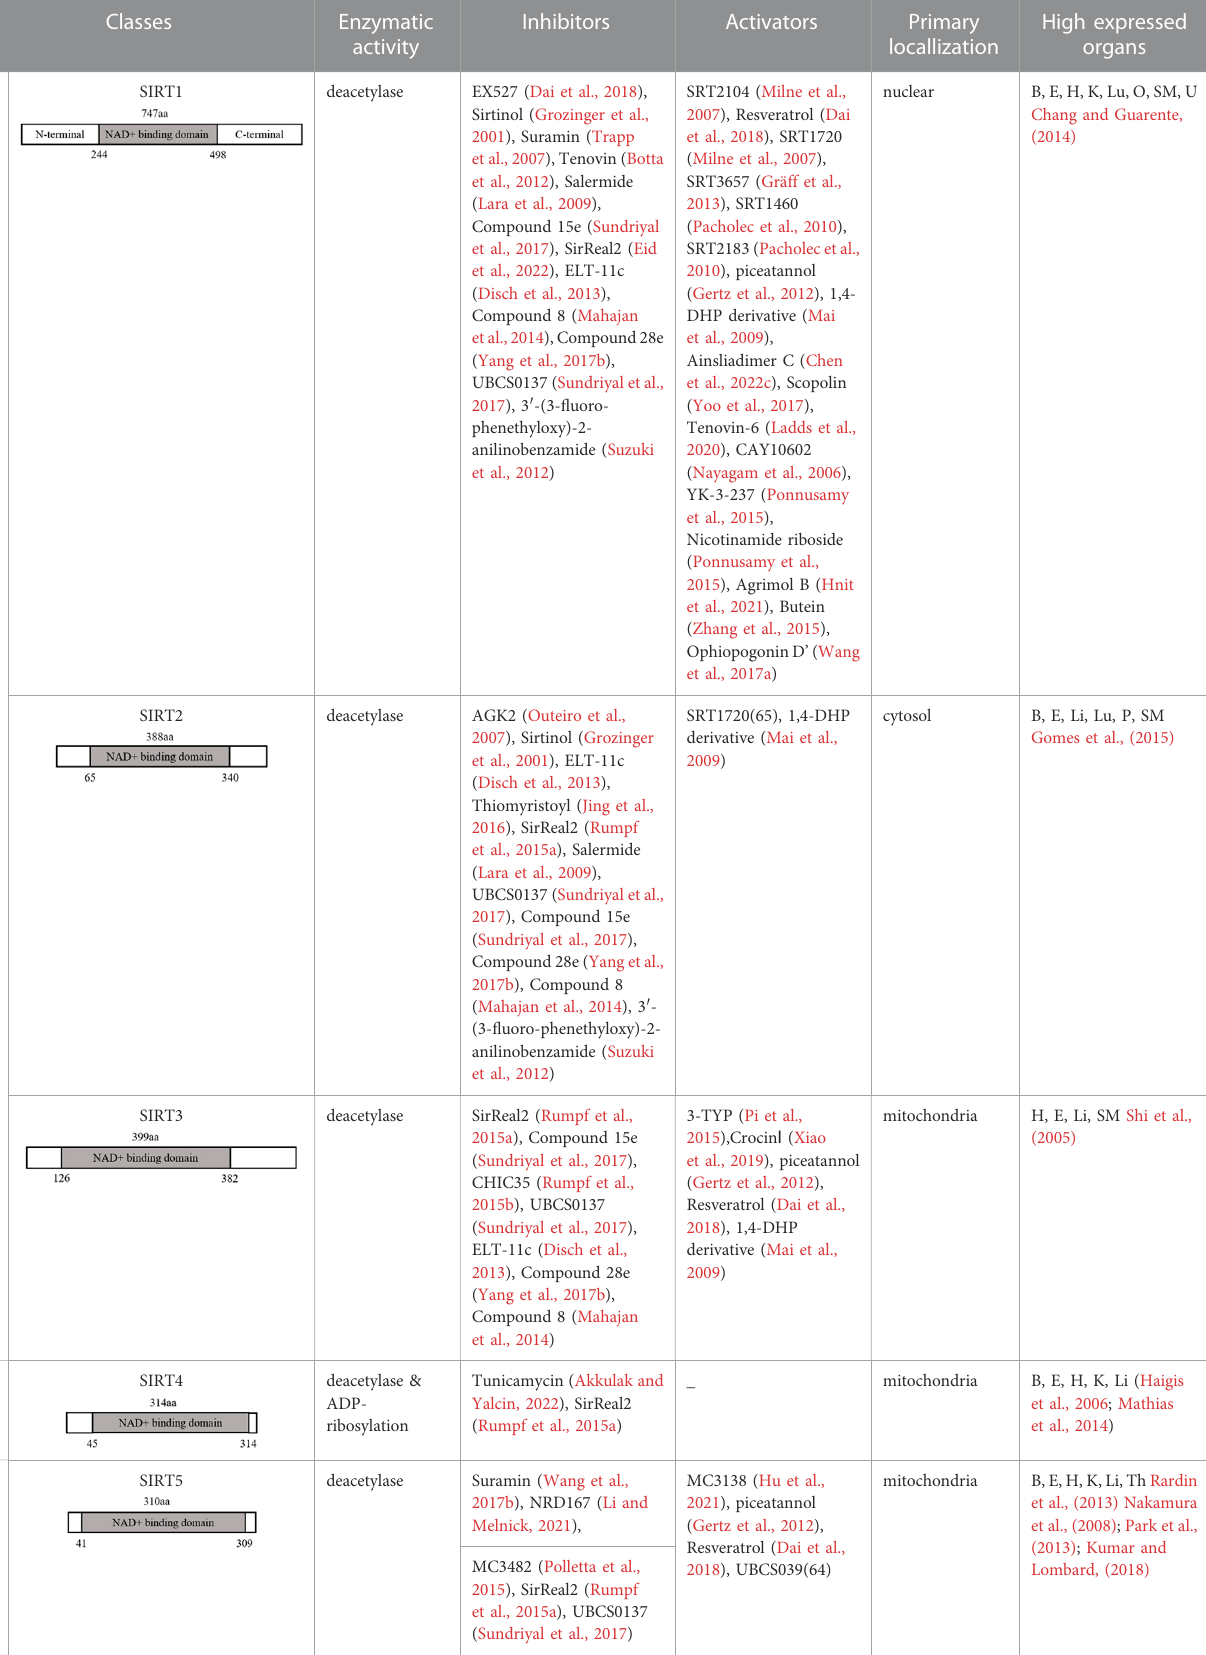
TABLE 1 Molecular structure, enzymatic activity, regulators, localization, and tissue expression patterns of